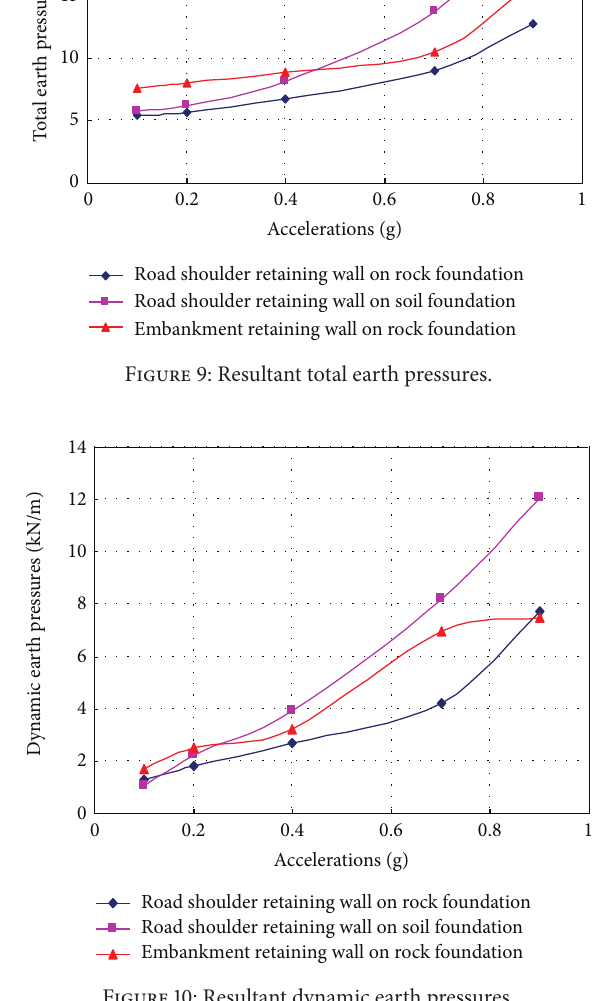
Figure 10: Resultant dynamic earth pressures.